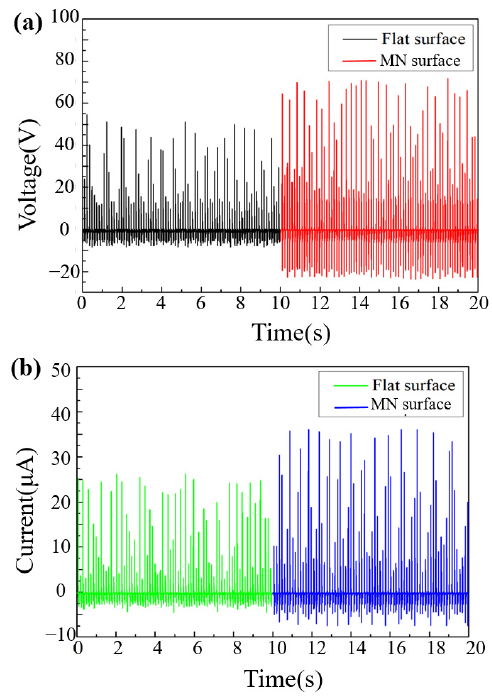
Figure 4. ( a ) Open circuit voltage and ( b ) current diagram of flat surface FTENG and 374 µ m microneedled structure